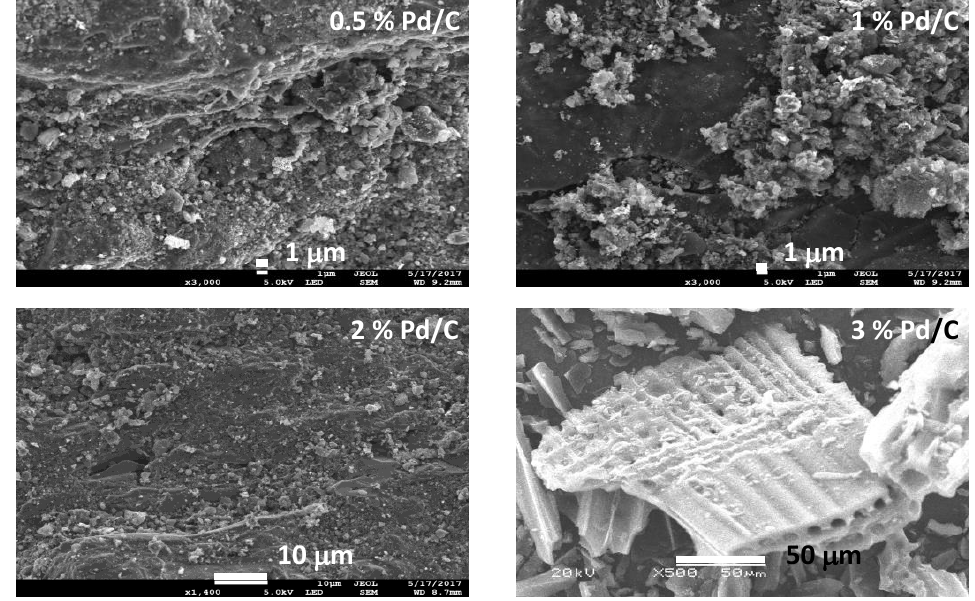
Figure 2. SEM images of the 0.5%, 1%, 2% and 3% Pd/C catalysts.